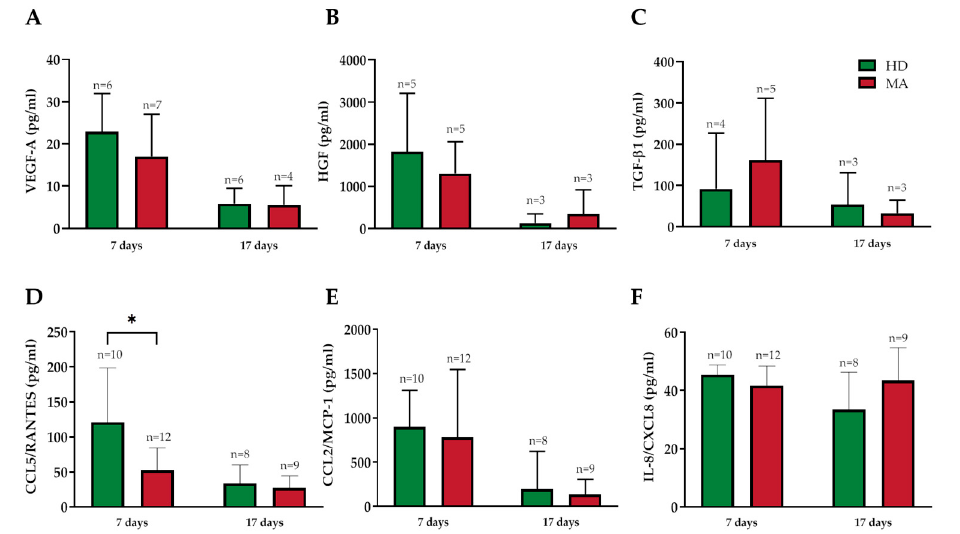
Figure 8. ( A ) Vascular endothelial growth factor A (VEGF-A), ( B ) hepatocyte growth factor (HGF), ( C ) transforming growth factor-beta 1 (TGF- β 1), ( D ) chemokine (C-C motif) ligand 5 (CCL5/RANTES), ( E ) chemokine (C-C motif) ligand 2 (CCL2/MCP-1), and ( F ) interleukin 8 (IL-8/CXCL8) concentration (pg/mL) in conditioned media collected from EPC cultures at 7 and 17 days